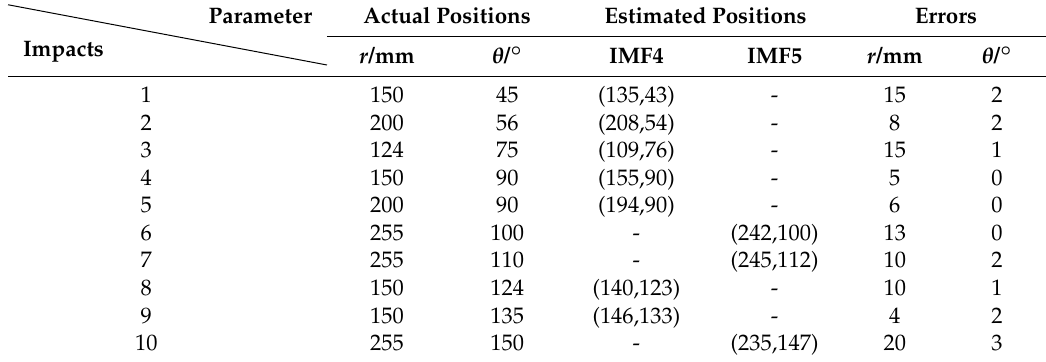
Table 1. The localization